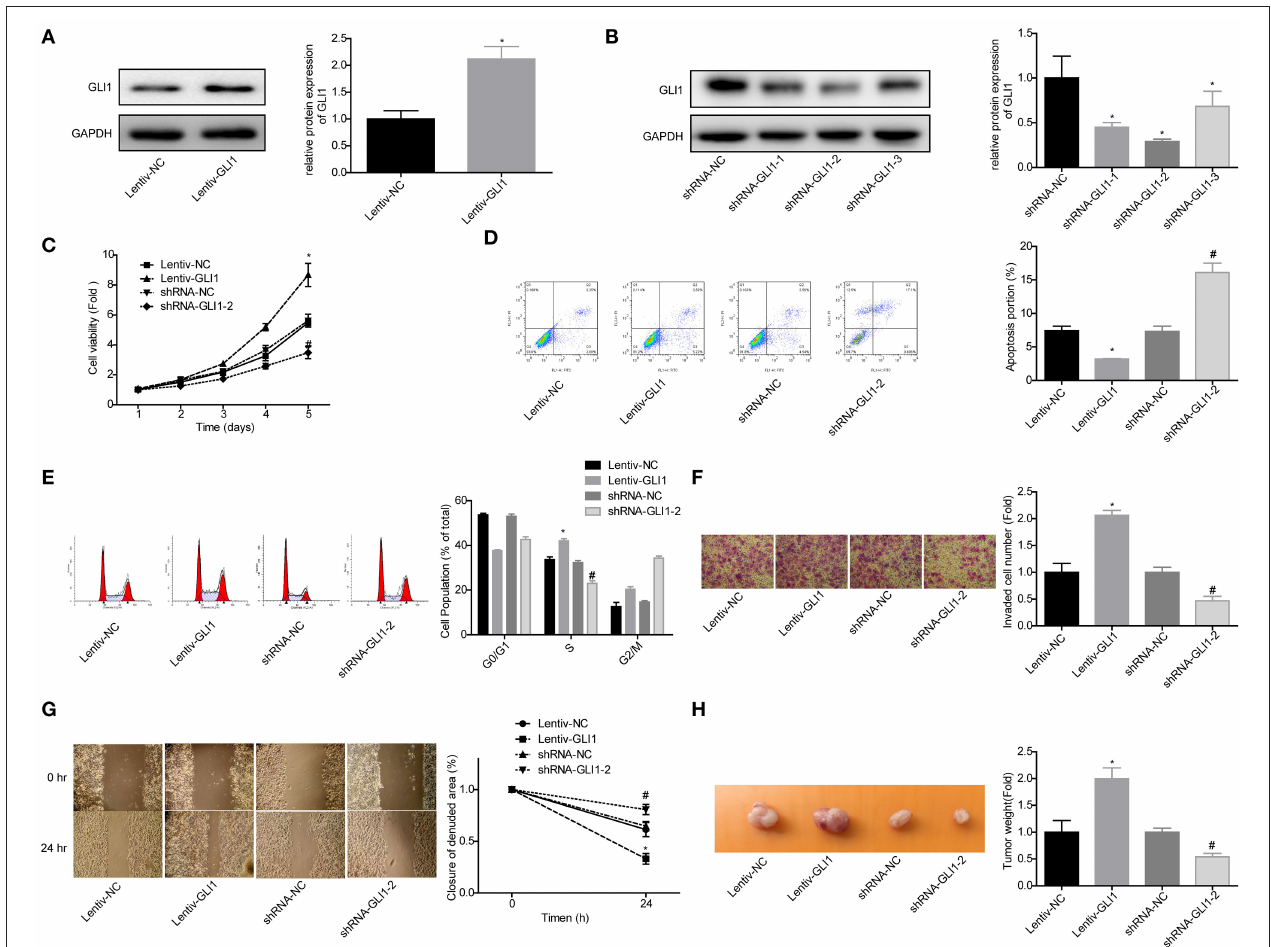
FIGURE 7 | GLI1 served as an oncogene in NB progression. (A,B) Western blot was taken to detect the infected efficiencies of Lentiv-GLI1 and shRNAs-GLI-shRNAs in SK-N-SH cells, * P < 0.05. (C) CCK-8 assay was taken to detect the proliferation of SK-N-SH cells. Flow cytometry assay was adopted to detect (D) cell apoptosis and (E) cell cycle. (F) Cell invasion and (G) migration in SK-N-SH cells were detected by using the transwell chambers and wound healing assay. (H) Xenograft model was established to detect the tumorigenesis of SK-N-SH cells. (* P < 0.05, vs. Lentiv-NC group, # P < 0.05, vs. shRNA-NC